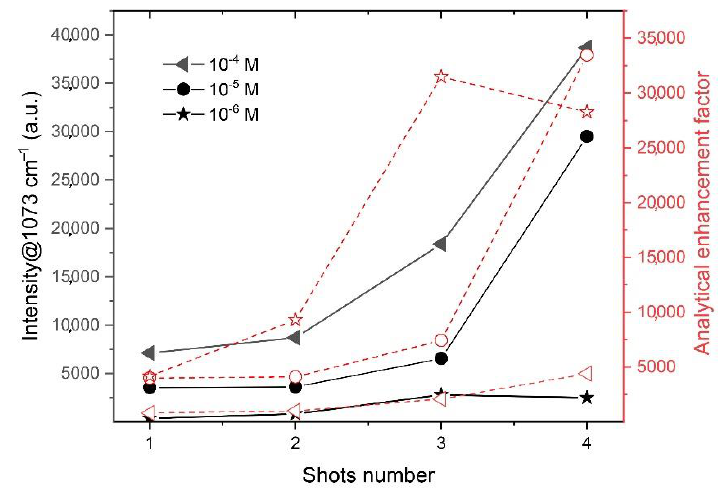
Figure 8. SERS intensity at 1073 cm − 1 obtained by 633 nm laser excitation and calculated analytical enhancement factor for different MPBA concentrations.